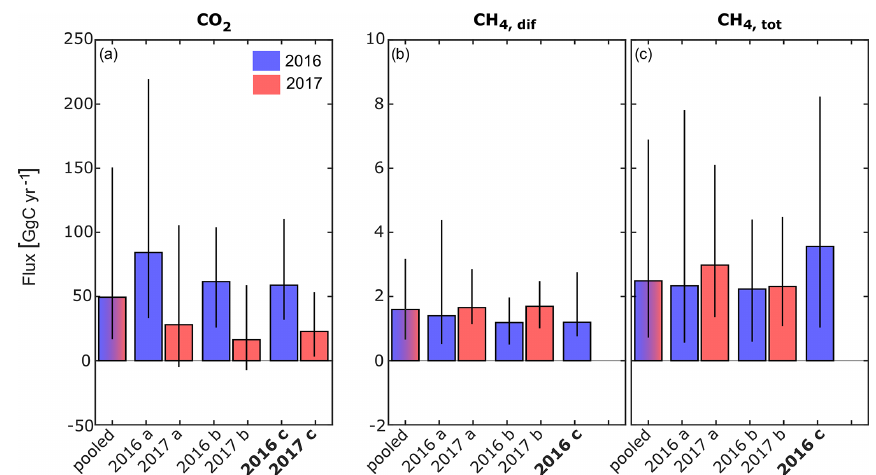
Figure 7. Comparison of greenhouse gas fluxes from the delta’s freshwaters to the atmosphere obtained by the different upscaling approaches, i.e. pooled, and cases “a” (discrimination by year), “b” (discrimination by year and waterscape) and “c” (discrimination by year, waterscape and month). Black vertical lines indicate the uncertainty when performing calculations using the 25 and 75 percentiles instead of median values. (a) CO 2 flux. (b) Diffusive and (c) total CH 4 flux. All fluxes are in GgCyr − 1 . Bold y axis labels indicate the calculation approach (case “c”), which is shown in more detail in Fig. 6 for the individual contributions from rivers, channels and